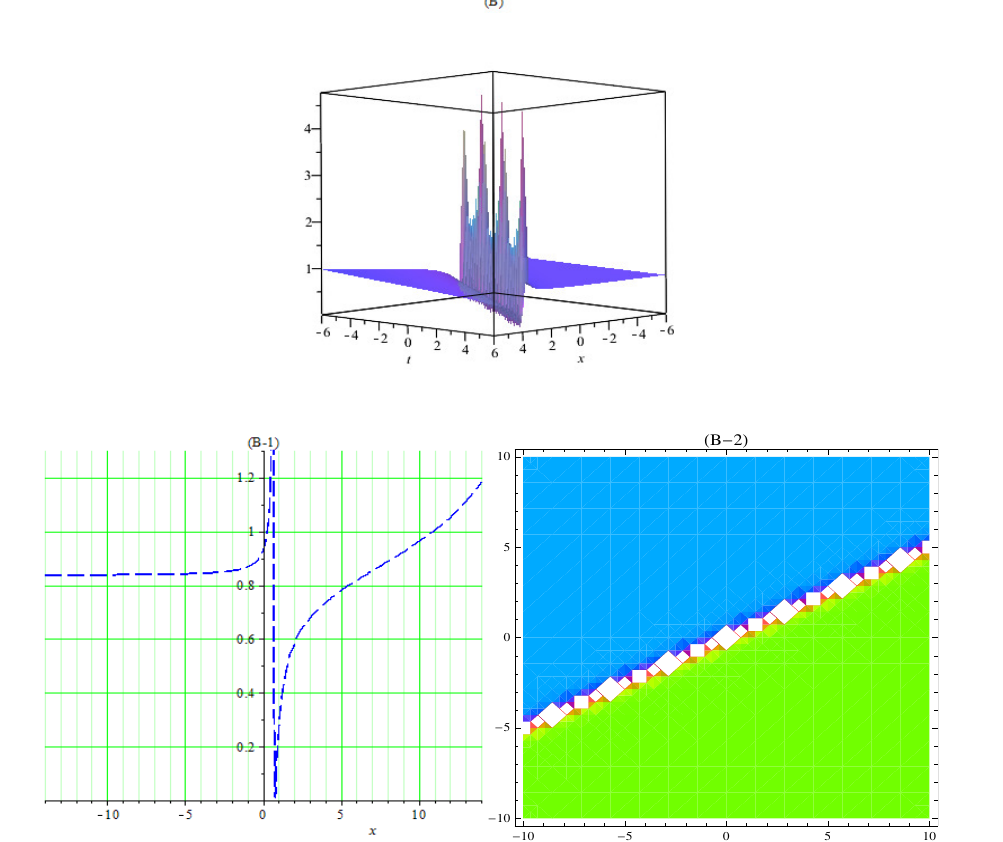
Figure 2. ( B ) 3D graph of singular soliton of (35) using l = 1.4, m = 0.4, µ = 0.6, g = − 0.7, ζ = 0.6, V = 0.4. ( B-1 ) 2D plot and ( B-2 ) contour plot of (35).